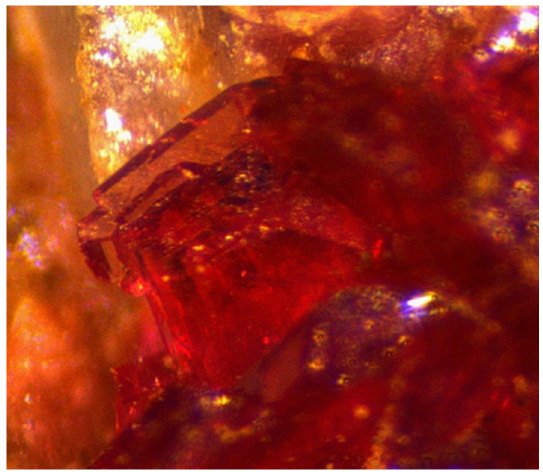
Figure 2. Microscope photo of roselite, catalogue no. 05802, field of view 0.5 mm.